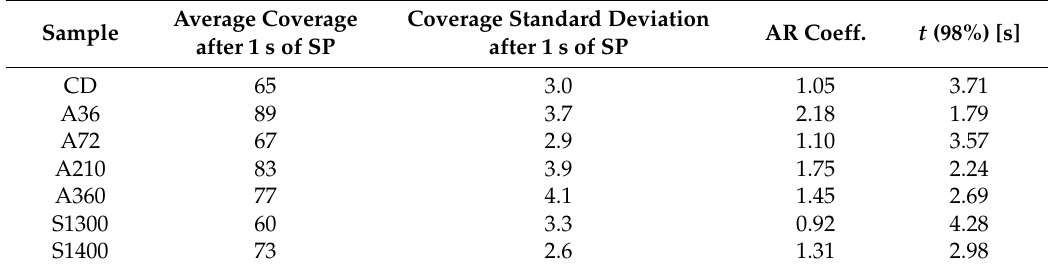
Table 2. Avrami equation